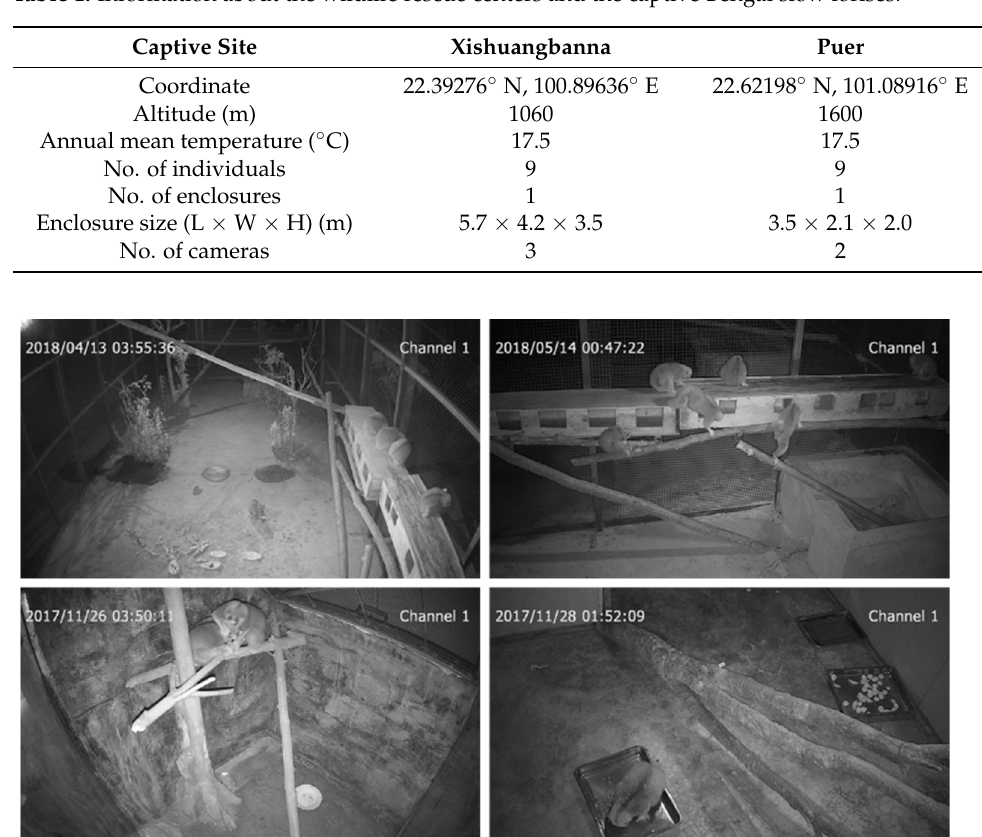
Table 1. Information about the wildlife rescue centers and the captive Bengal slow lorises.